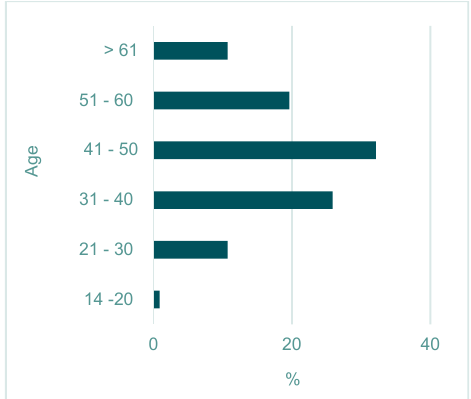
Figure 7. Number of responses by gender.